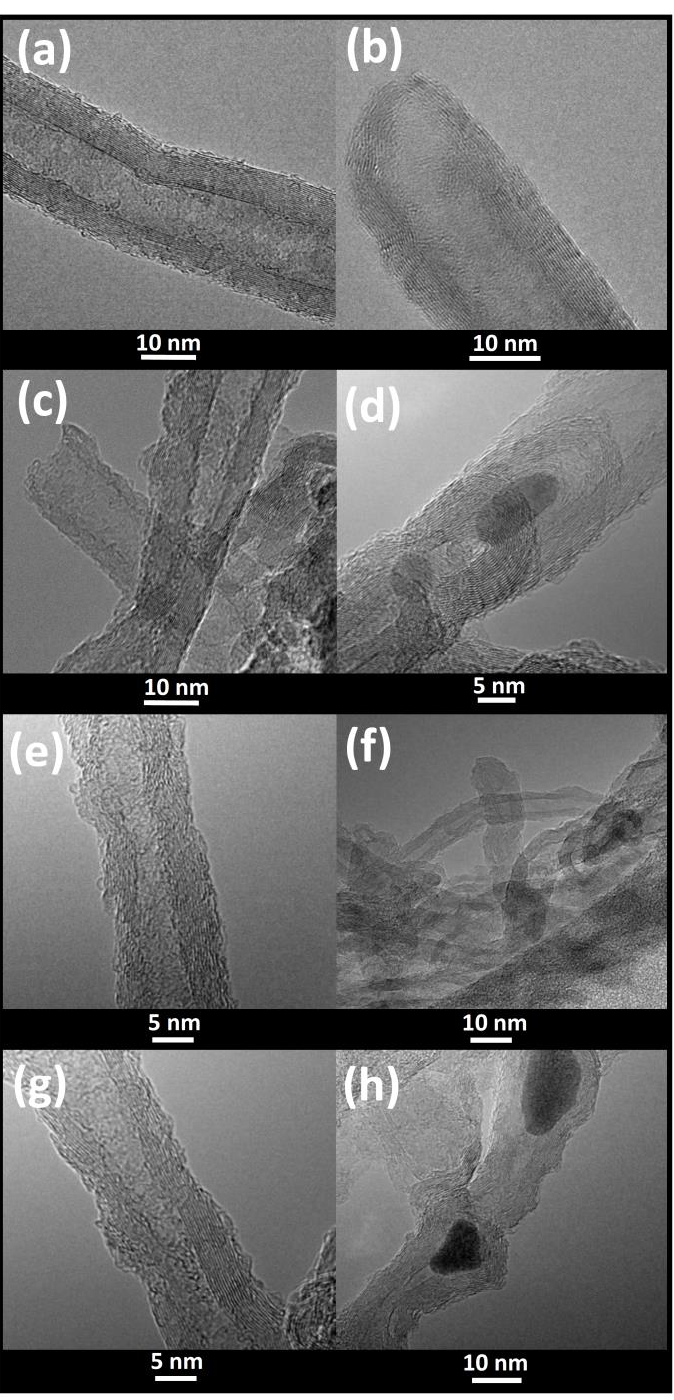
Figure 7. Example TEM images of high resolution for MWCNTs-COOH ( a ), MWCNTs-COONH 4 ( b ), MWCNTs-COONH 4 ground with the agate mill ( c , d ), and MWCNTs-COOH ground with the agate mill ( e , f ) and the steel mill ( g , h ). In ( d ) and ( h ), large Fe-nanoparticle built-in MWCNTs are visible. Some small metallic nanoparticles bound within the walls of carbon nanotubes are visible as dark spots ( e , g